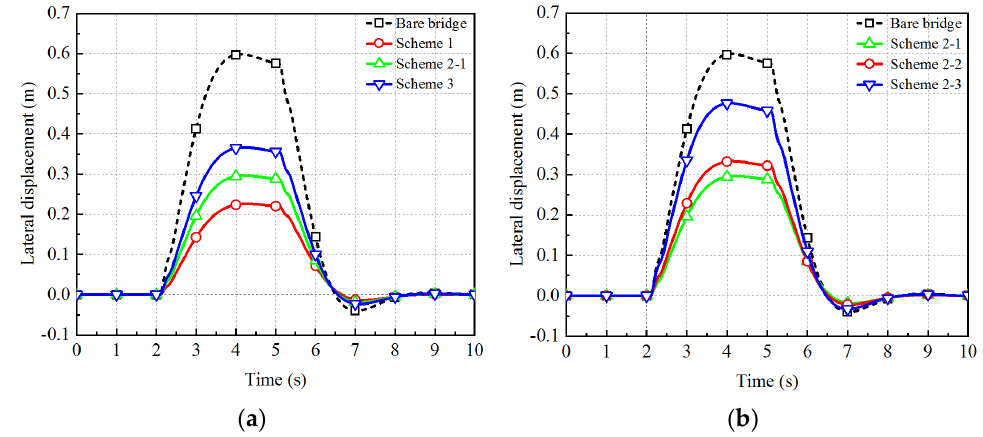
Figure 20. Lateral displacement with different bridge wind barriers (( a ) Different porosity scheme; ( b ) Different height scheme).